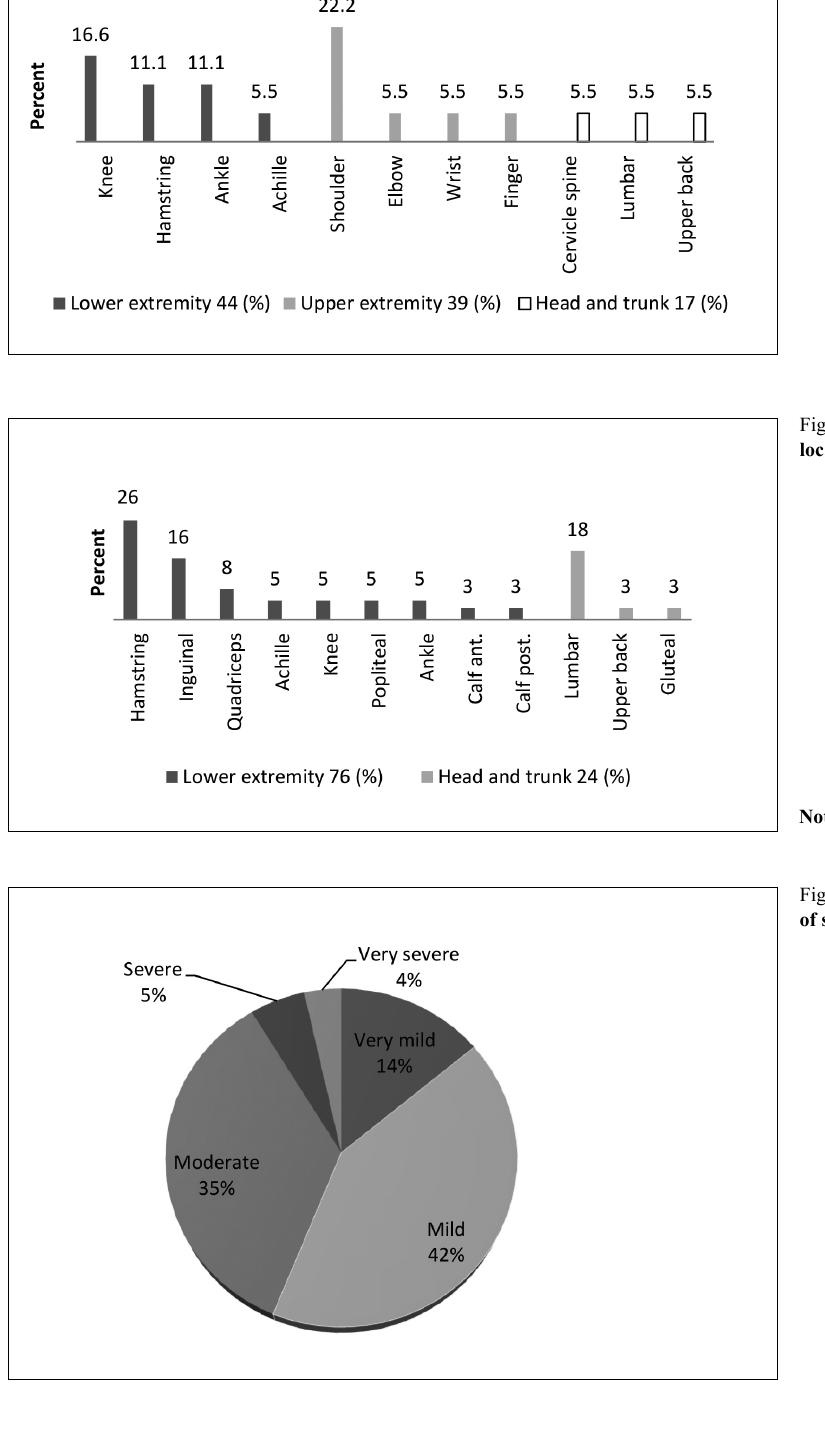
Figure 2. Injury places by body region and